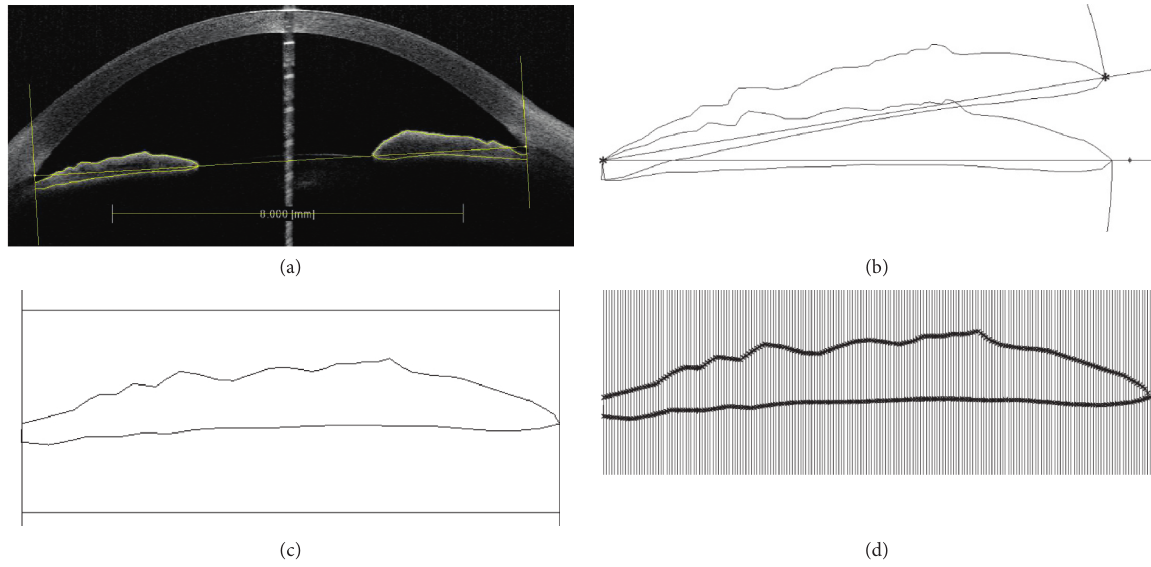
Figure 1: Measurements of iris thickness at 199 points. (a) Scleral spurs (SS) at both sides were identified; vertical lines through the SS that were perpendicular to the lines connecting the two SS, together with the anterior and posterior iris surface, defined the border of the iris. (b) After the background bitmap was removed, the iris was rotated so that the line connecting the end of the lateral anterior iris surface and pupillary margin ( ∗ ) became horizontal. (c) The image was recalibrated, and two horizontal lines parallel to the line connecting the anterior iris root and pupillary margin were drawn above and below the iris as references. (d) The iris was then divided into 200 sections by 199 equally spaced vertical lines across the iris with a specially edited path in the Grasshopper plug-in. The iris thickness was defined as the length of the vertical line between the anterior and posterior borders of the iris, point 1 referred to the first location from the lateral side, point 2 was the second, and the rest was deduced by analogy.